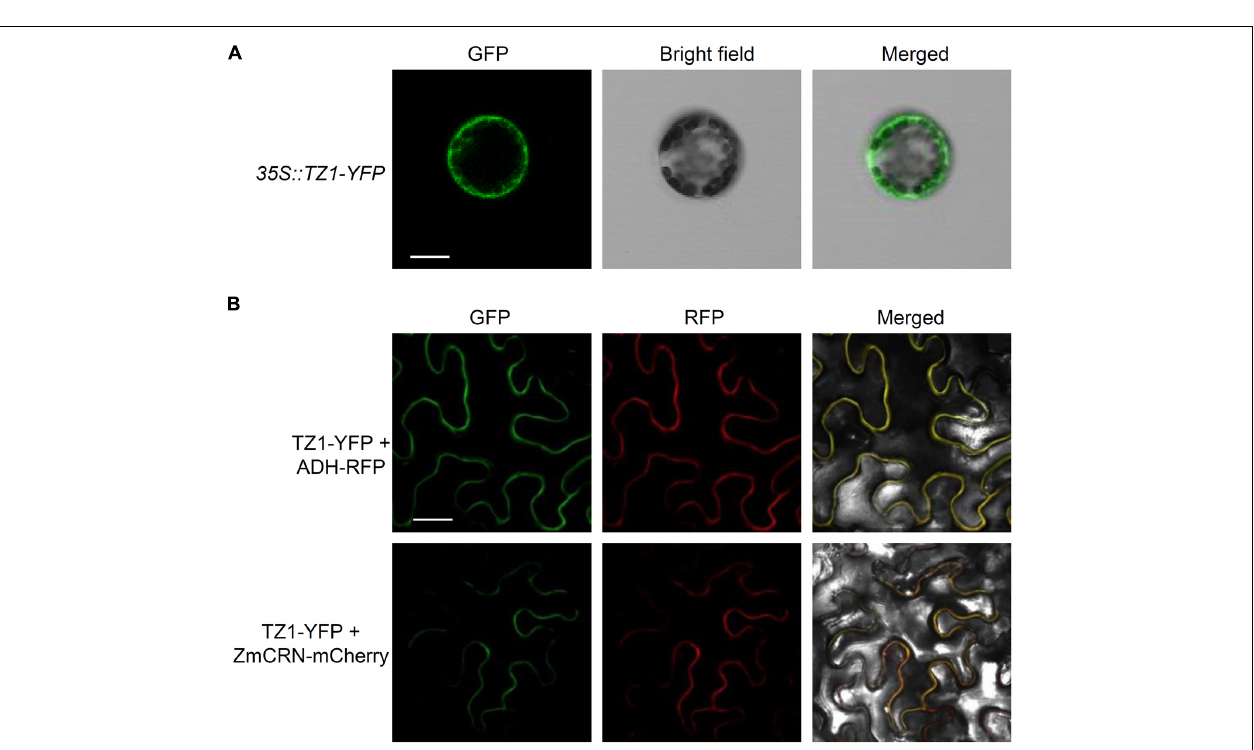
FIGURE 3 | Subcellular localization of TZ1. (A) Plasmids containing genes encoding TZ1 protein and YFP protein were introduced into protoplasts of Arabidopsis mesophyll cells. Fluorescent and bright field images are shown. Scale bar, 50 µ m. (B) Laser-scanning confocal images of TZ1-YFP fusion protein transiently expressed in Nicotiana. benthamiana leaf cells with ADH-RFP as a cytosolic maker or ZmCRN-mCherry as a plasma membrane maker. GFP: green fluorescent protein. RFP: red fluorescent protein. Scale bar, 50 µ m.